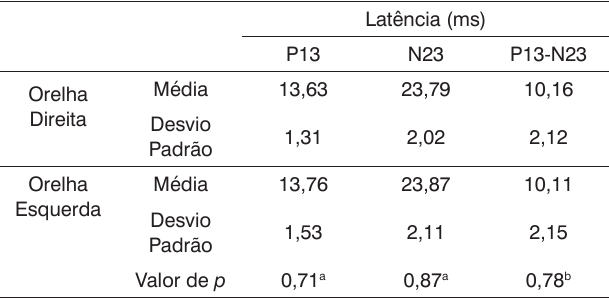
Tabela 2. Valores de latência do VEMP, do gênero masculino, por orelha.